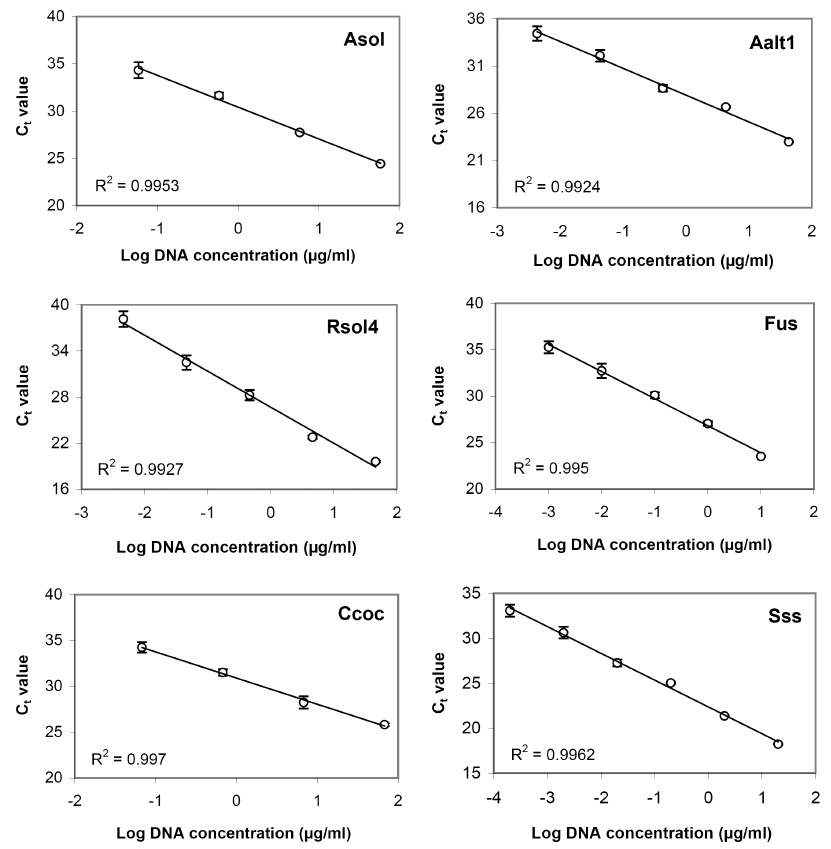
Figure 2. Standard regression curves of serial dilutions of DNA from the target potato pathogens.